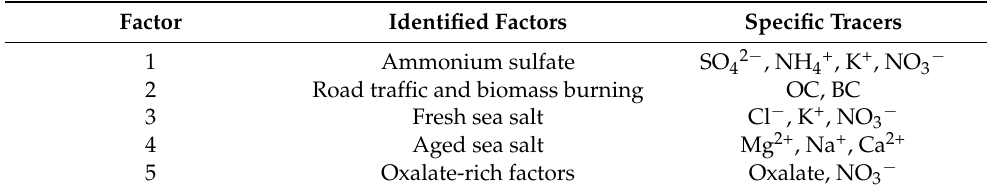
Table 4. Summary of PMF-resolved sources and their specific tracers. Figure 4. PM 2.5 factor profiles obtained by PMF model using the BC, OC, and chemical concentra- tions in Tetouan for the 2011 – 2012 period. Blue bars show the normalized concentration of the spe- cies (µg/m 3 ) in the factor, while the red dots show the percentage of that species in the factor.